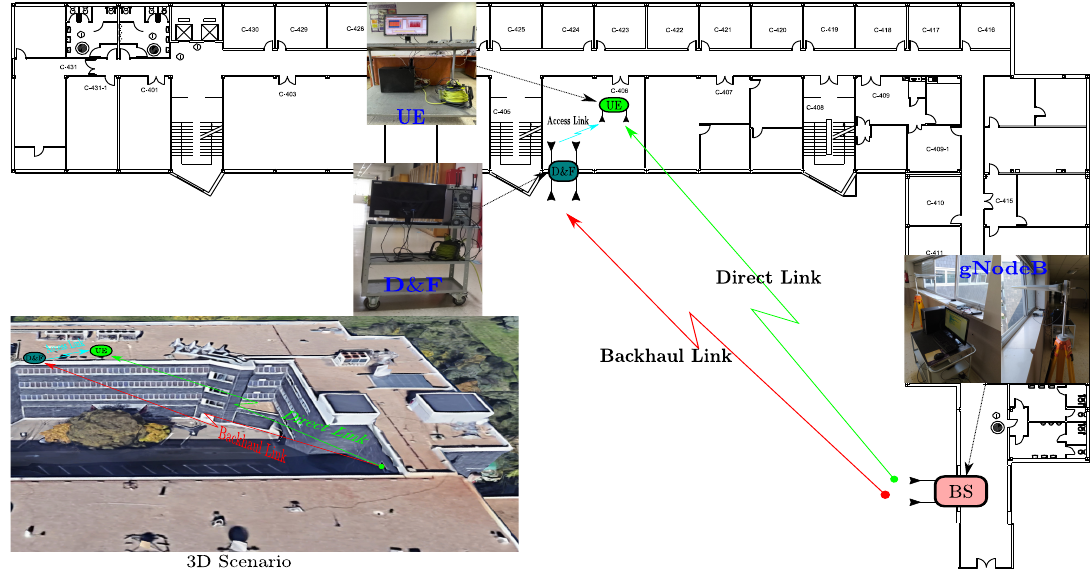
Figure 7. Overview of the testbench nodes and the experimentation scenario of the proposed D&F relay node co-operative 5G